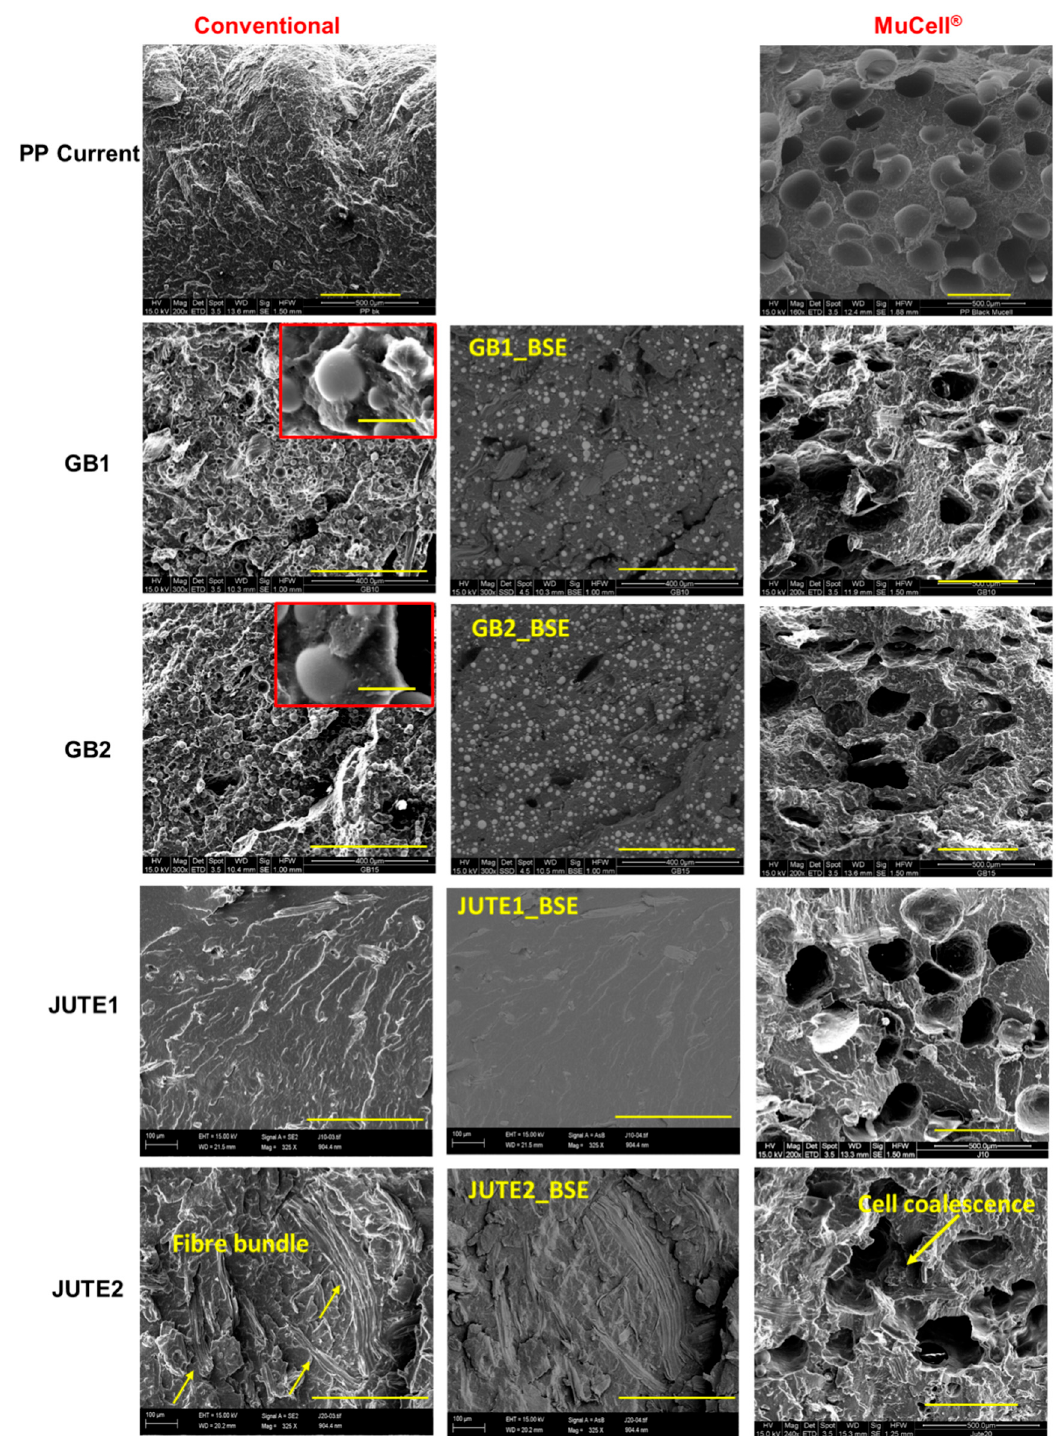
Figure 1. SEM images of the cryofracture surface morphology of GB1, GB2, JUTE1, JUTE2, and PP Current using conventional and MuCell ® injection moulding. Note: The scale in the individual images represents 400 µm, whilst the scale in the two inserted images represents 25 µm.